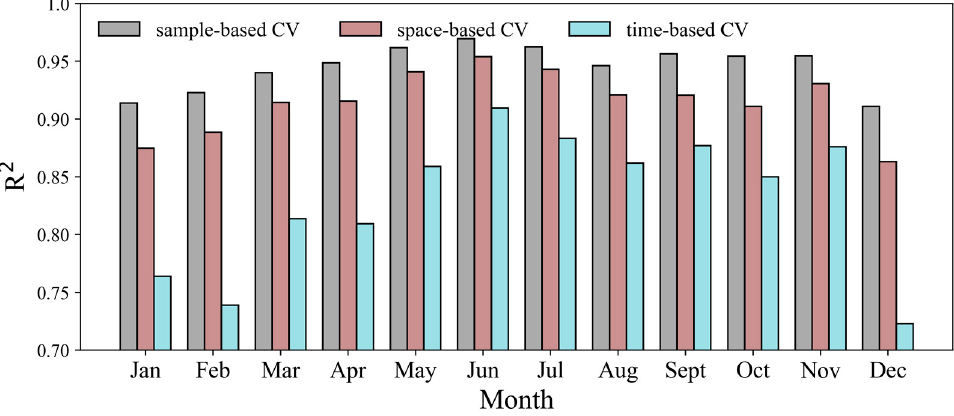
Figure 6. Individual month CV results.